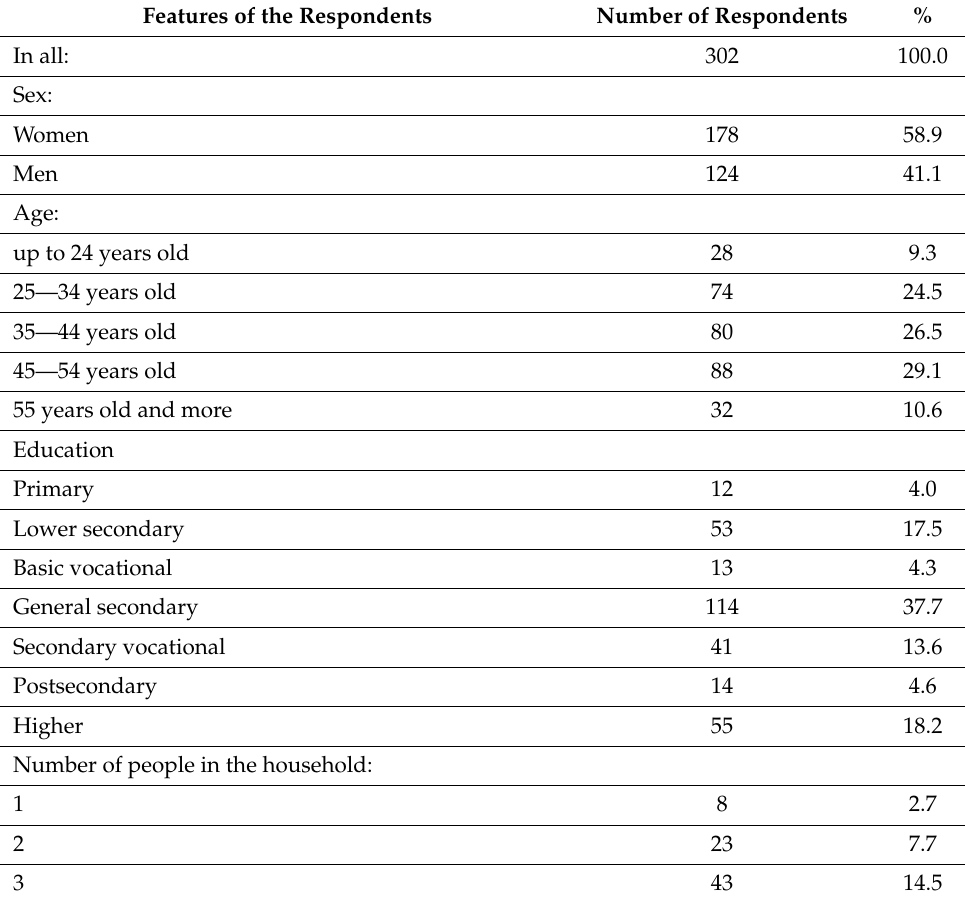
Table 1. Structure of respondents and their